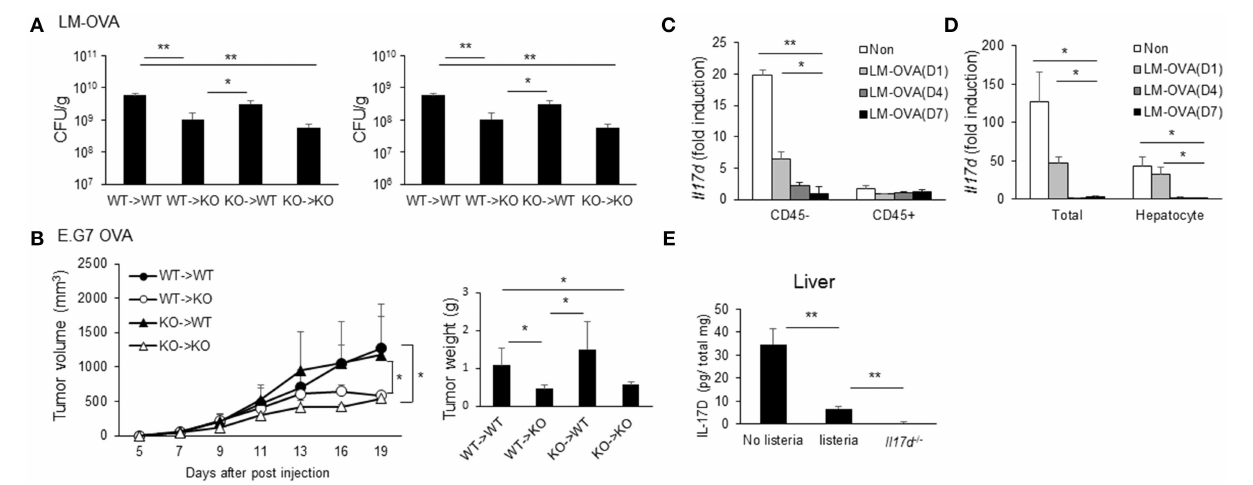
FIGURE 7 | Non-hematopoietic compartments of IL-17D contribute to pathogenicity. (A,B) WT or Il17d − / − BM cells were transferred to irradiated WT or Il17d − / − mice ( n = 3–4 per group). Eight weeks after BM reconstitution, LM-OVA (A) or EG.7 OVA lymphoma cells (B) were injected, and bacterial burden or tumor growth was measured. (C,D) WT mice were killed on days 1, 4, and 7 after LM-OVA infection. (C) Expression of IL-17D on CD45 + or CD45 − cells in the liver. (D) Expression of IL-17D in total liver tissues and isolated hepatocyte. (E) Expression of IL-17D in total liver tissues by ELISA. Data are representative of three independent experiments. * p ≤ 0.05, ** p ≤